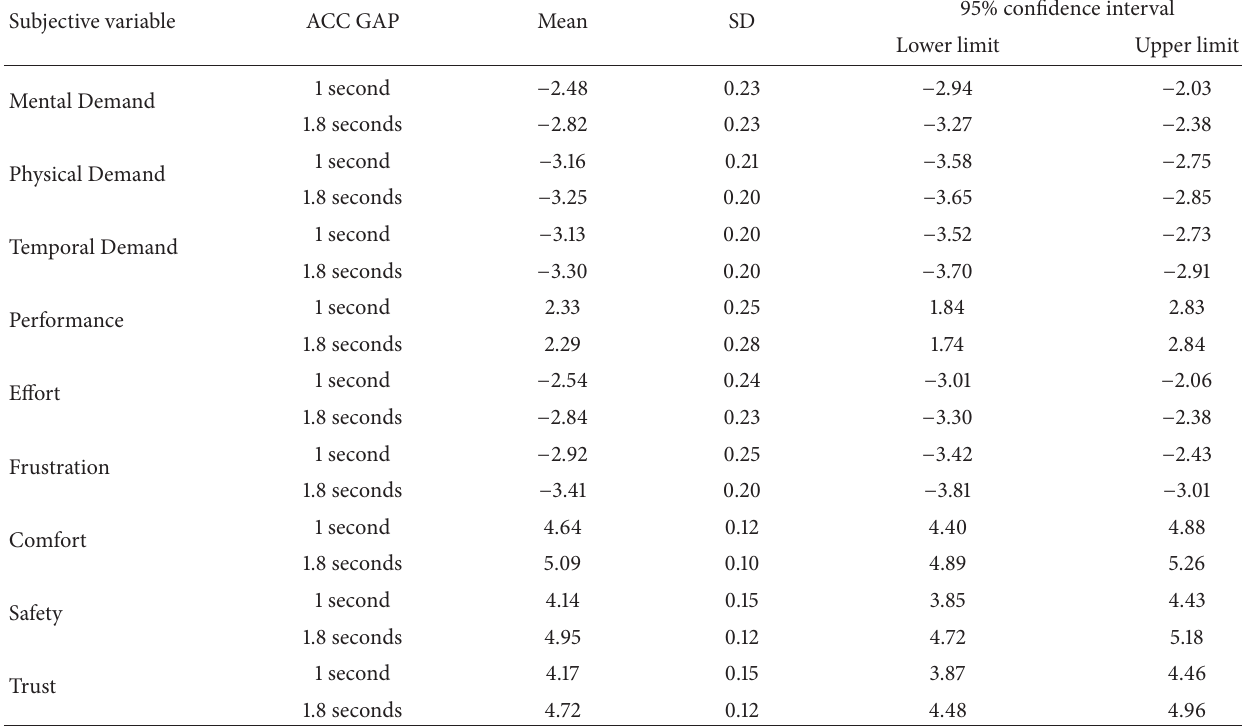
Table 4: Drivers’ self-ratings of workload, comfort, safety, and trust related to driving with different time gaps of the ACC ( 𝑁 = 96 ). Subjective